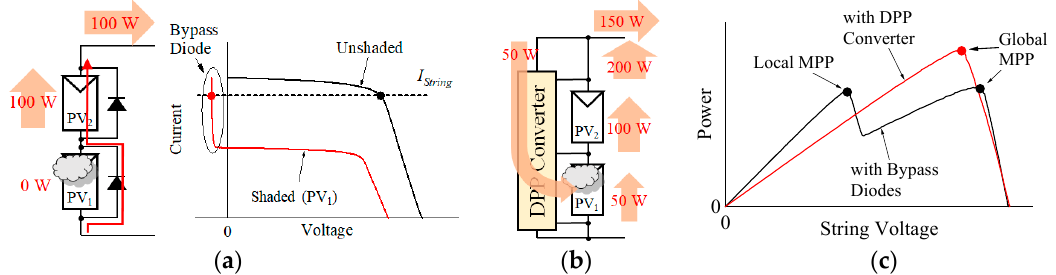
Figure 1. ( a ) Bypassed photovoltaic (PV) module due to partial shading, ( b ) power distribution in a di ff erential power processing (DPP) converter, ( c ) string characteristics with bypass diode or DPP converter.